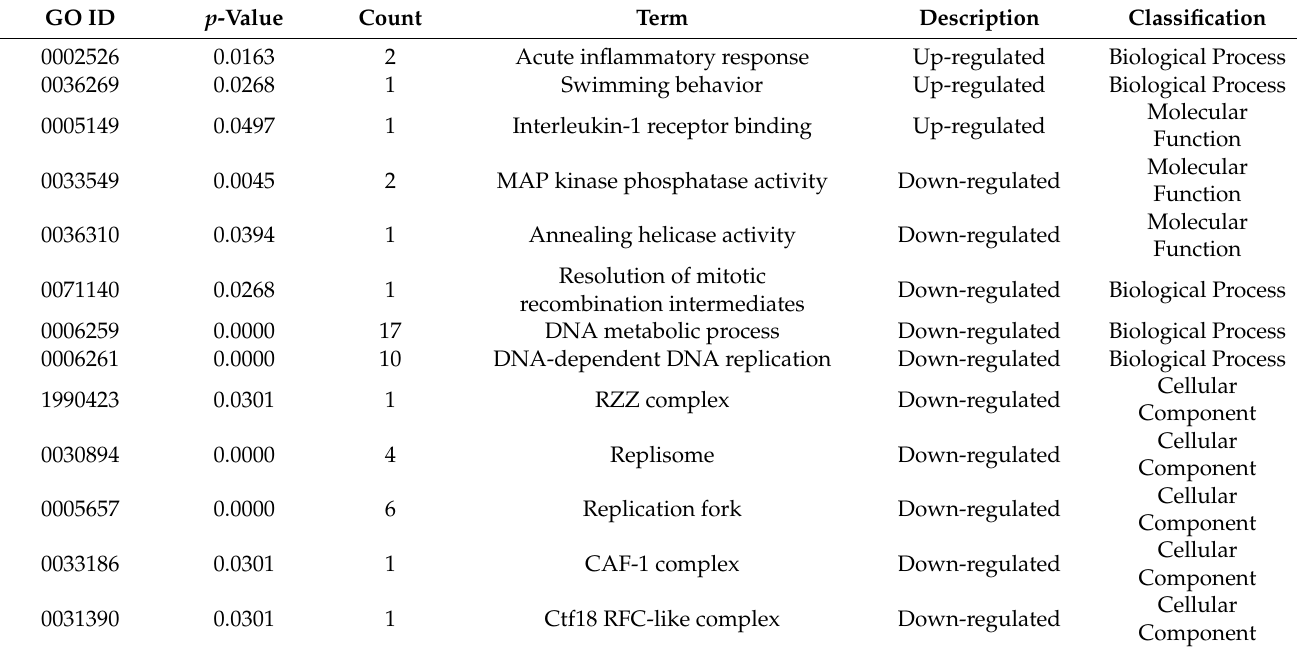
Table 3. GO (Gene Ontology) enrichment results after the abrupt temperature rise